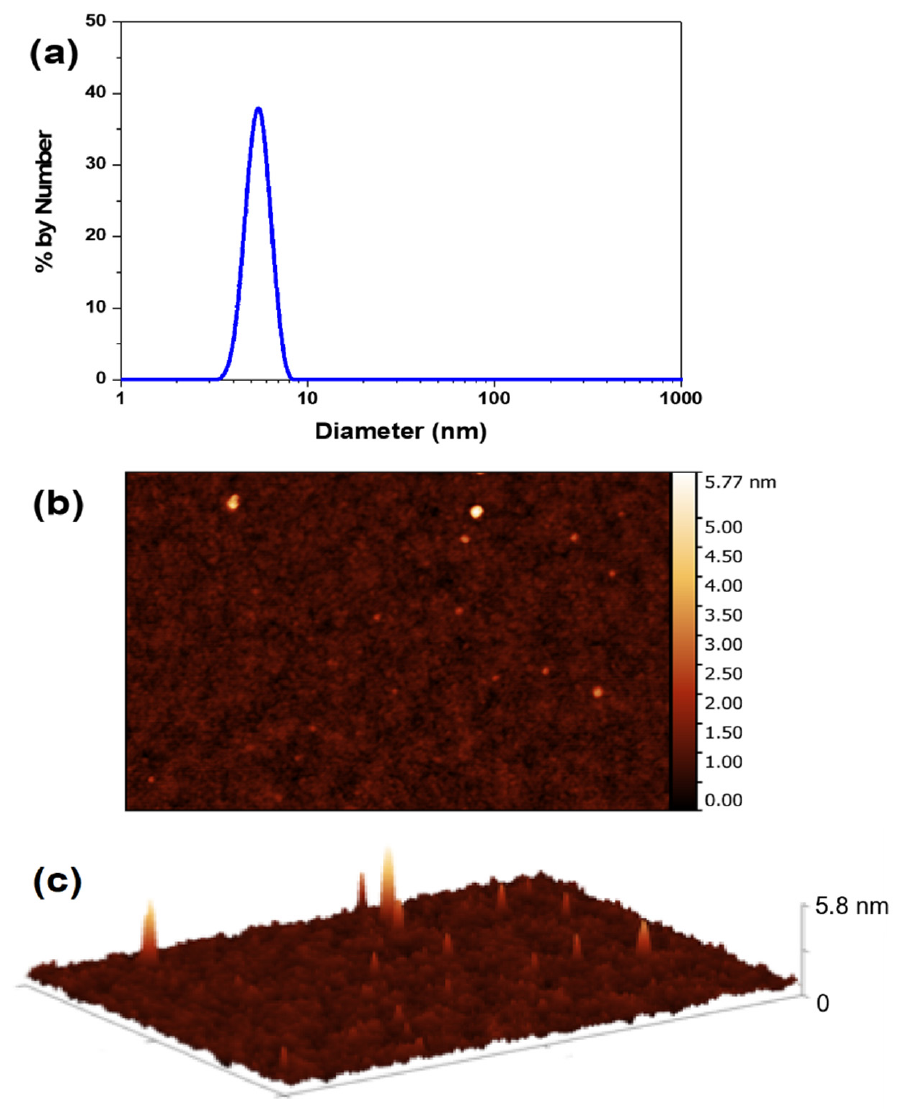
Figure 3. ( a ) DLS data obtained for CNDs in aqueous solution. ( b ) 2D AFM height image of CNDs deposited on a mica surface. ( c ) 3D topographic AFM image of CNDs deposited on a mica surface. The size of the CNDs was also analyzed in the solid-state by AFM using a Park NX10 Atomic Force Microscope, with an out-of-plane resolution of 0.006 nm. The sample was prepared by adding a drop of CNDs aqueous solution into a freshly cleaved mica surface. Figure 3b,c show the 2D AFM height image and the 3D topographic AFM image of the CNDs on the mica surface. In this AFM equipment, spherical nanoparticles result in circular bidimensional profiles observed on the image’s plane. Therefore, it is possible to infer that the heights indicated by the color scale of the AFM image correspond to the diameters of the individual particles. The AFM images reveal the presence of semispherical nanoparticles with average dimensions of 3.0 nm (sizes vary between 2.0 nm and 5.8 nm). When comparing the values obtained by DLS and AFM these values are consistent because the size obtained by DLS refers to the nanoparticle’s hydrodynamic